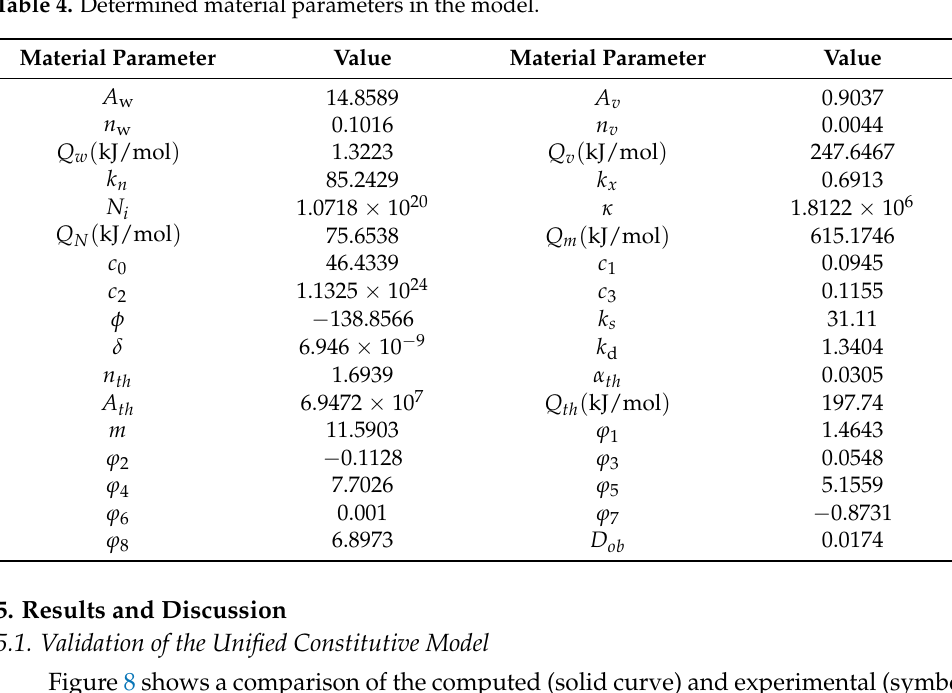
Table 4. Determined material parameters in the model.